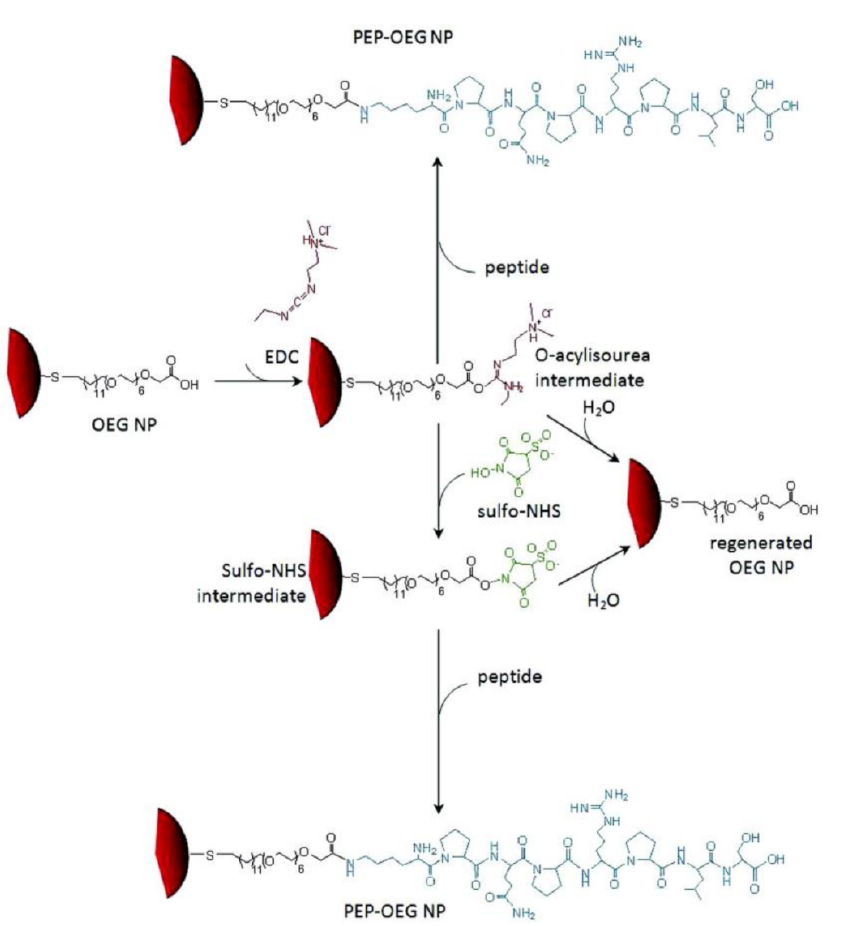
Figure 2. Schematic representation of amide bond formation between the KPQPRPLS peptide and OEG NPs by using EDC and Sulfo-NHS. The degree of peptide coupling as well as the colloidal stability of PEP-OEP NPs are strongly dependent on the experimental conditions (such as EDC and Sulfo-NHS concentrations, peptide concentration, reaction time, and reaction buffer) (Adapted from Bartczak and Kanaras 2011 [58], Copyright 2011 The American Chemical Society and reproduced with